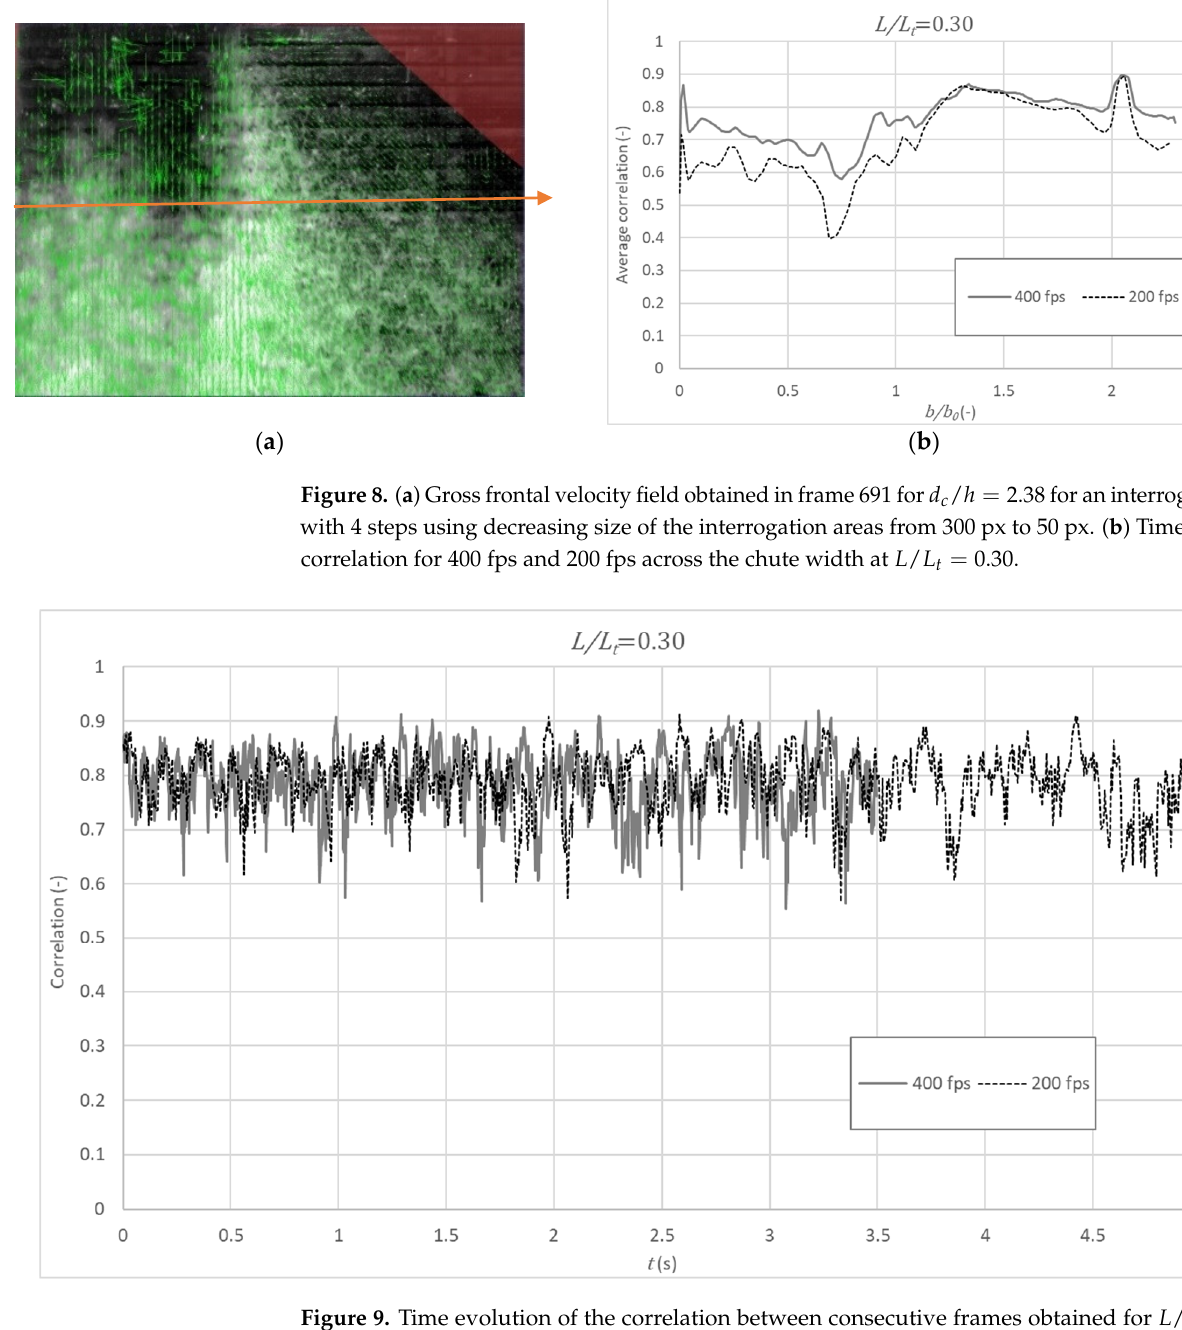
Figure 9. Time evolution of the correlation between consecutive frames obtained for L / L t = 0.30, b / b 0 = 1.17, d c / h = 2.38, and 200 fps or 400 fps.